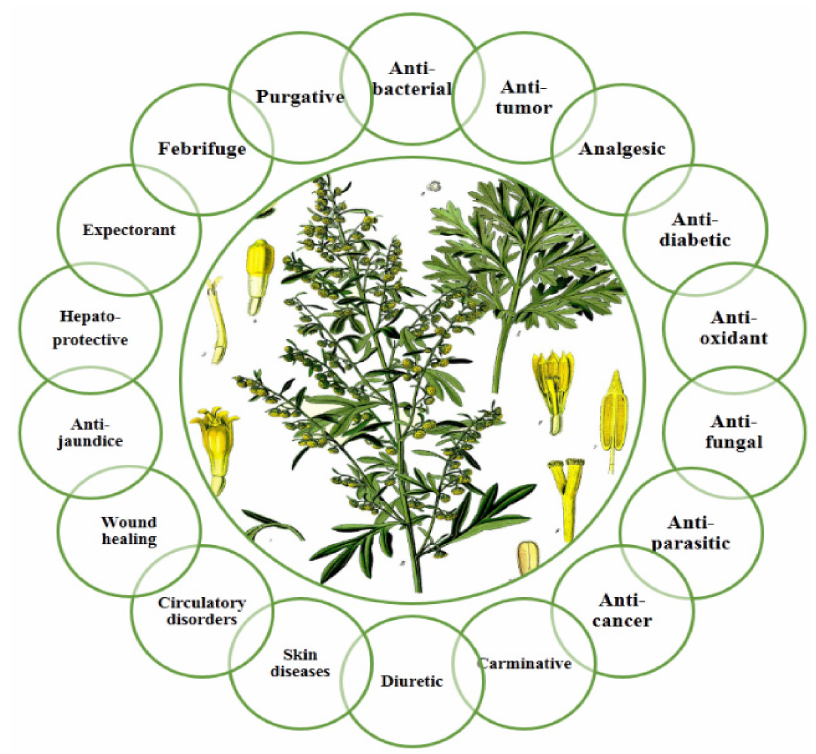
Figure 1. Health benefits of Artemisia